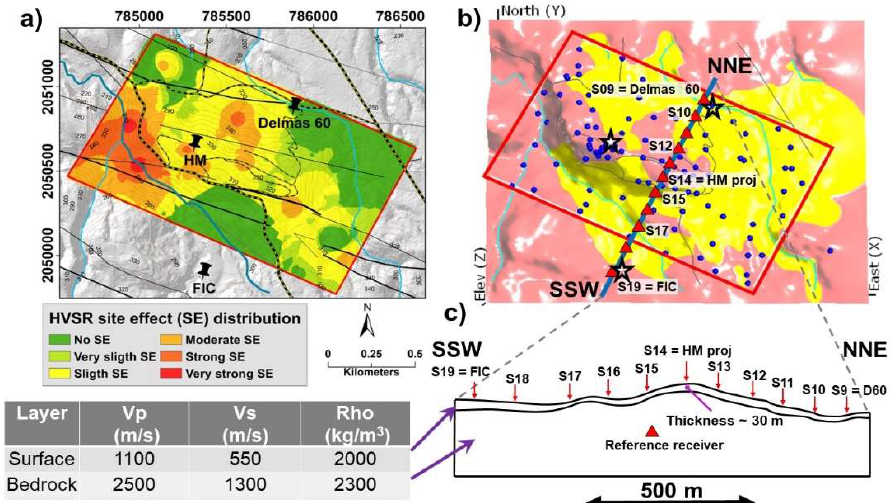
Figure 6. Map ( a ) outlines the distribution of the combined HVSR resonance frequency and peak amplitude site effect characteristics. ( b ) Map-view of the geomodel with stars marking the station locations and triangles the location of surface receivers in the numerical model presented in 3.3. ( c ) Section used for numerical modelling, including a simplified single layer (see indication of approximate 30 m thickness on top of the hill)—on top of bedrock structure, with main elastic properties described in the table to the left. Sx indicates the surface receiver locations; a reference receiver was included inside the bedrock.